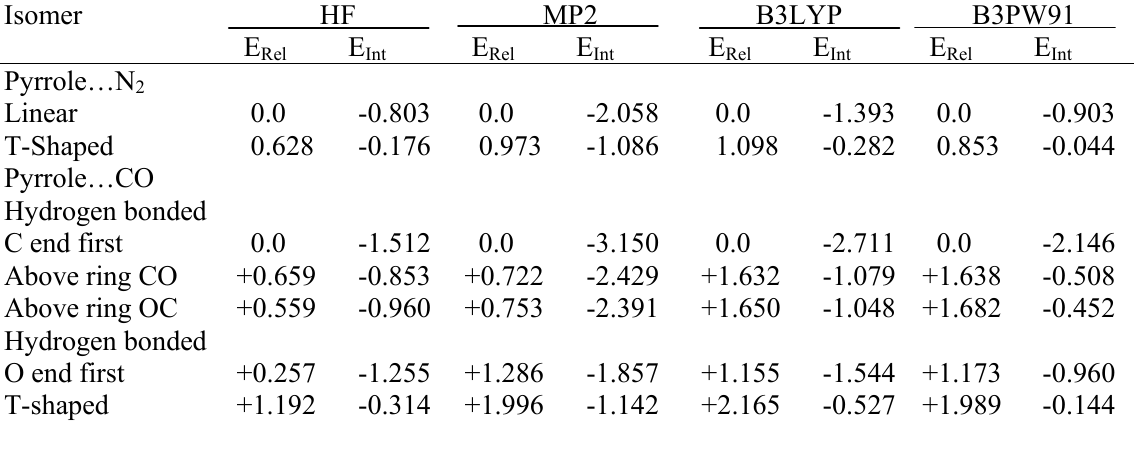
Table 2 . Relative energy orderings (in kcal/mol) (E ) for the various isomers of the pyrrole…nitrogen and the pyrrole..CO complexes BSSE (E Int